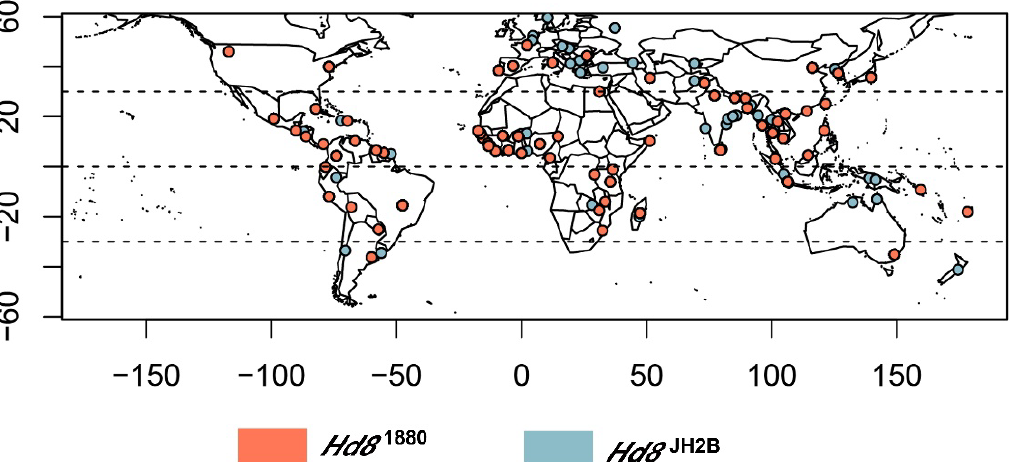
Figure 9. Geographical distribution of Hd8 1880 and Hd8 JH2B haplotypes. The orange dots represent the geographical distribution of the haplotype Hd8 1880 , and the cyan dots represent the geographical distribution of the haplotype Hd8 JH2B .